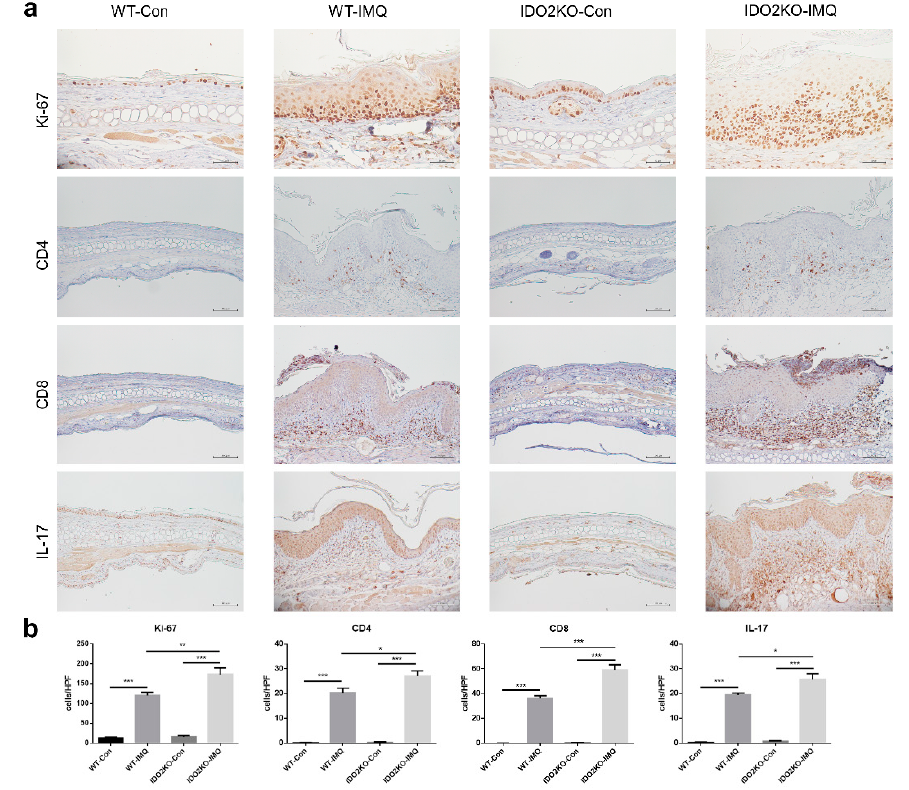
Figure 4. Keratinocyte proliferation and inflammatory cell infiltration are significantly increased in IDO2 KO mice treated with IMQ. ( a ) Immunohistochemical staining of the ear of WT and IDO2 KO mice treated with vehicle or IMQ for 7 days using Ki-67, CD4, CD8, and IL-17 antibody. Ki-67 antibody, scale bar = 50 µm; CD4, CD8, and IL-17 antibody, scale bar = 100 µm. ( b ) The number of Ki67 + cells in the epidermis and infiltrating CD4 + , CD8 + , and IL-17 + lymphocytes in the dermis per high power field. Data are presented as mean ± SEM. * p < 0.05, ** p < 0.01, *** p < 0.001 (one-way